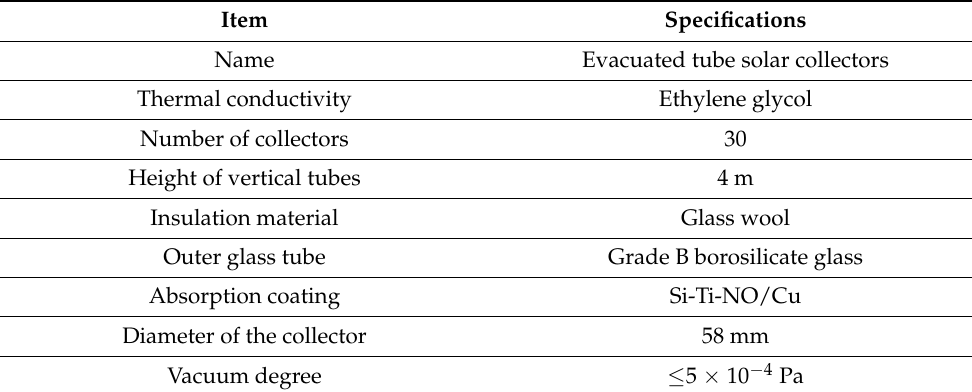
Figure 18. BIM model of collector system. Table 6. Specifications of heat collector tube.